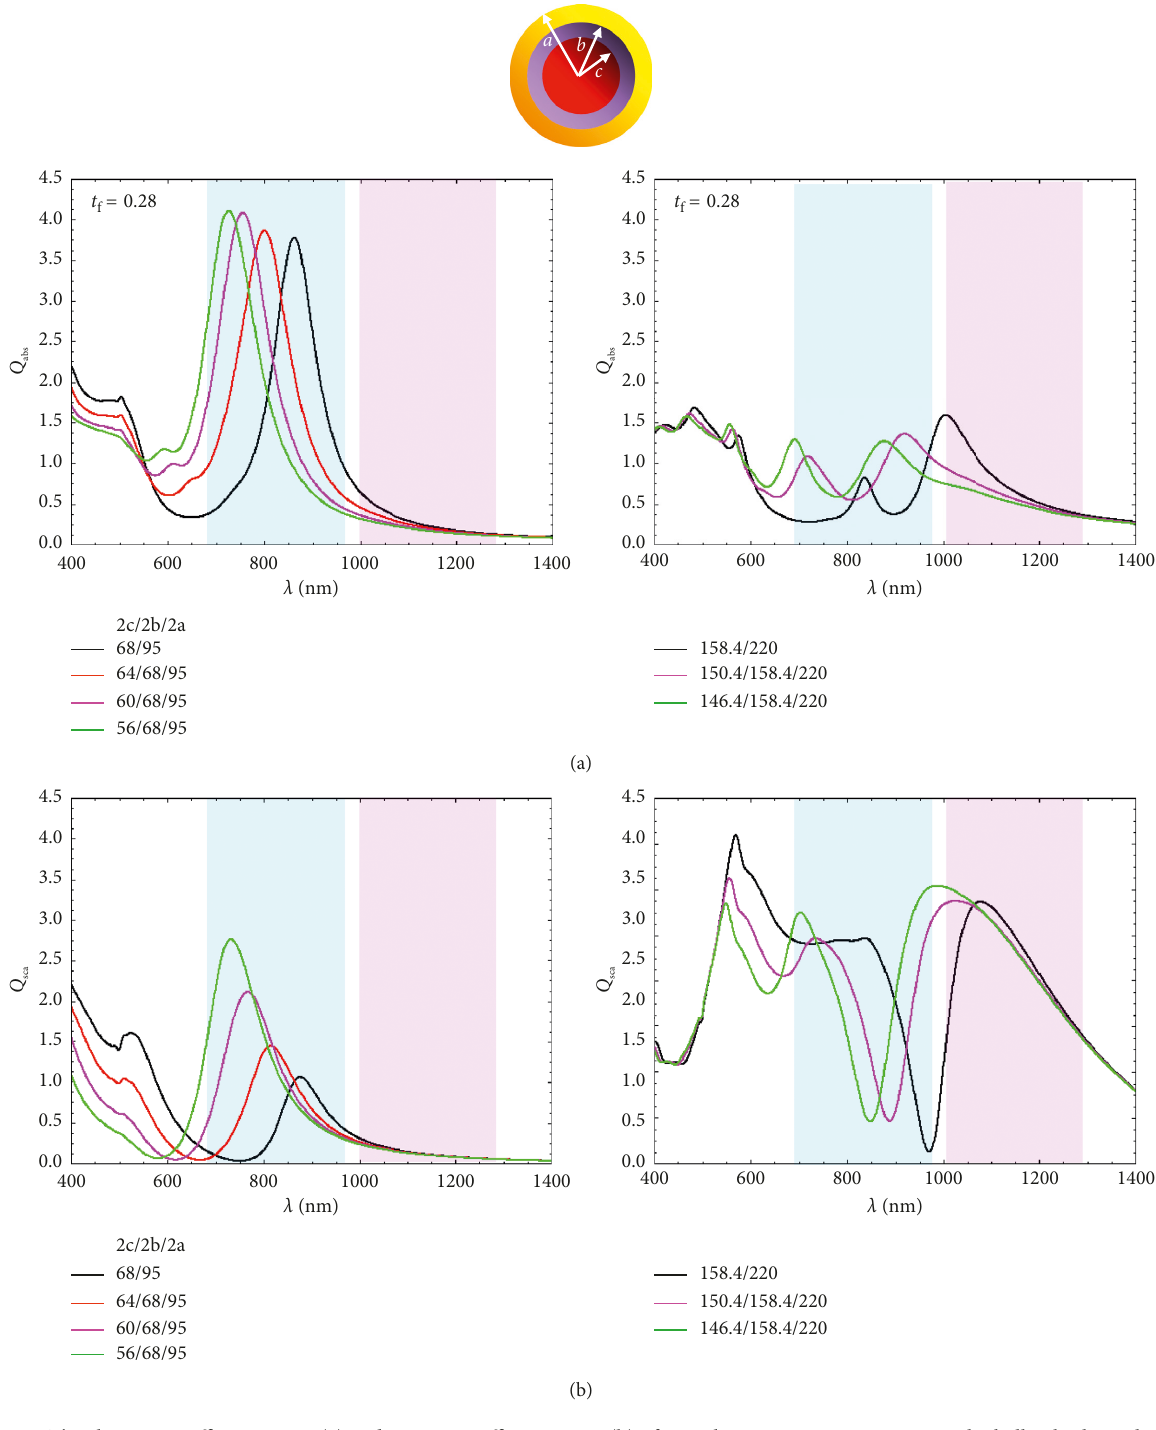
Figure 6: The absorption efficiency Q abs (a) and scattering efficiency Q sca (b) of a single Si/SiO 2 /Au concentric multishell in biological tissues as a function of the incident light wavelength λ for different silica shell thicknesses but fixed particle diameter and fixed gold shell